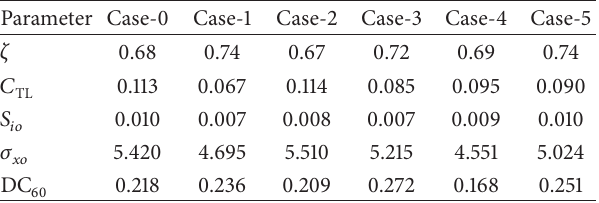
Table 3: Values of performance parameters for all the cases of